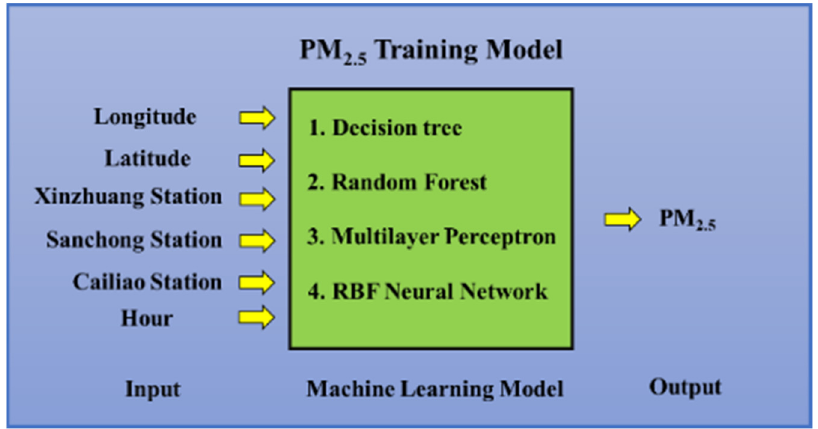
Figure 9. Structure of the PM prediction model.